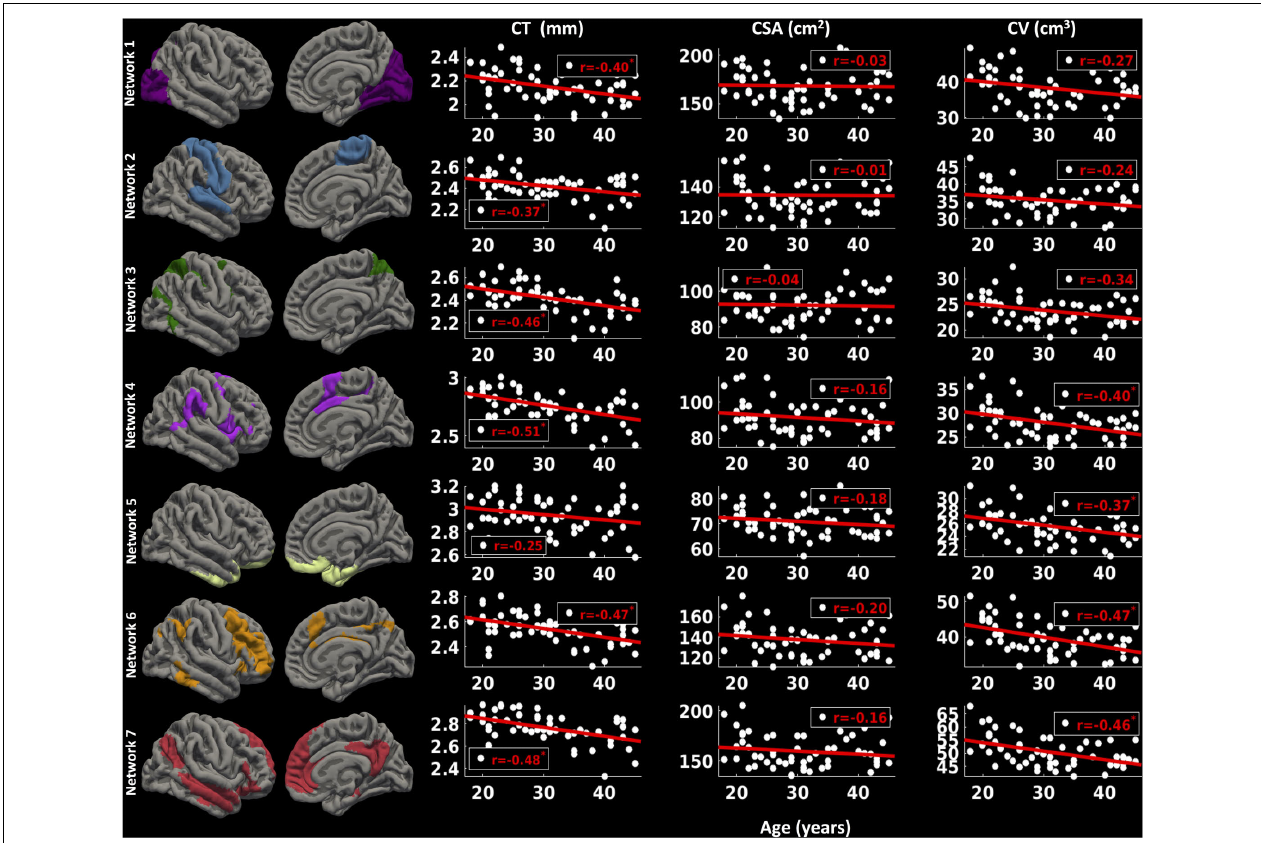
FIGURE 7 | Network-wise age-related changes in cortical measures for right hemisphere. Linear plots showing significant reduction in cortical thickness (CT in mm) ( ∗ p < 0.05, corrected for multiple comparisons), non-significant reduction in cortical surface area (CSA in cm 2 ) and significant or trend toward significant reduction in cortical volume (CV in cm 3 ) ( ∗ p < 0.05, corrected for multiple comparisons) for seven functional networks on right